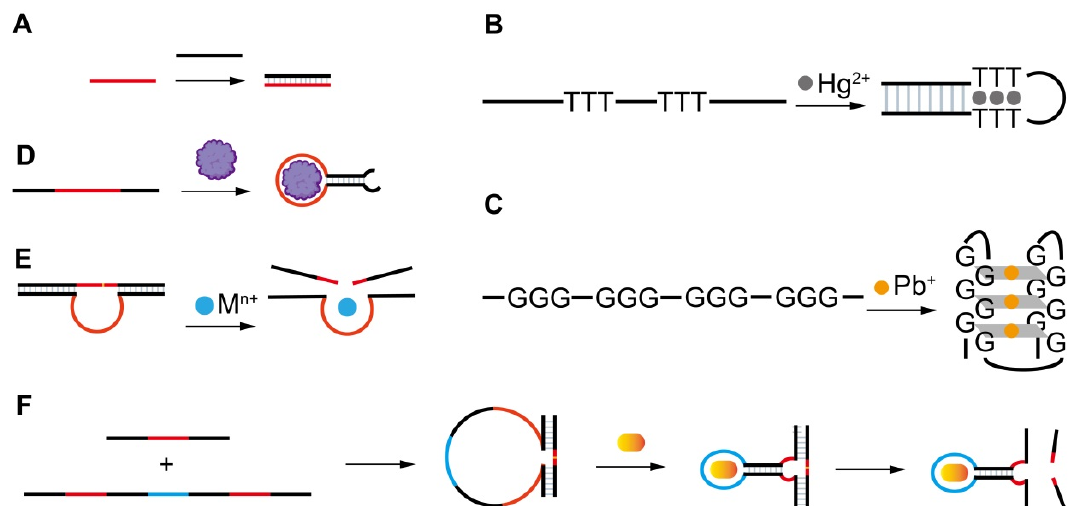
Figure 2. The arti fi cial FNAs most popularly used in biosensors including FNA-FOEW sensors. ( A ) Complementary DNA probe (cDNA); ( B ) rationally designed thymine (T)-rich probe for highly speci fi c Hg 2+ detection; ( C ) rationally designed guanine (G)-rich probe for highly speci fi c Pb 2+ detection; ( D ) aptamers; ( E ) DNAzymes speci fi c to various metal ions; ( F ) aptazymes for nonmetal ion targets.